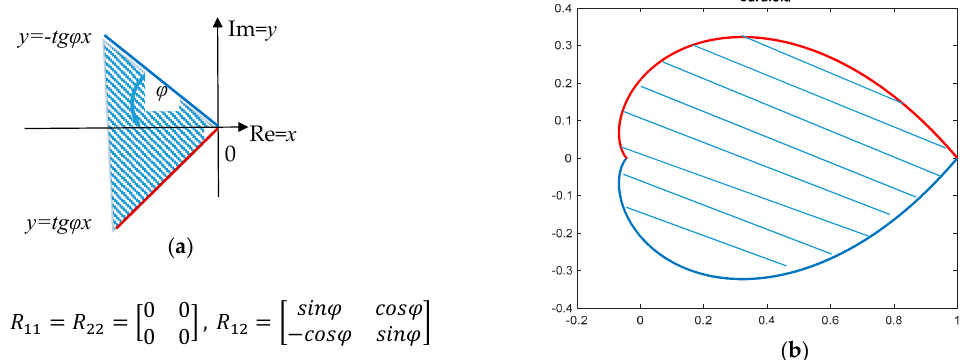
Figure 2. Pole regions for the prescribed stability degree (corresponding to the system exponential decay rate). ( a ) Continuous-time system: Shifted left half plain of the convex plane; ( b ) discrete-time systems: Interior of the “shrinked” unit circle – circle centered in [0,0] with radius 1/sqrt( α ), where α > 1.